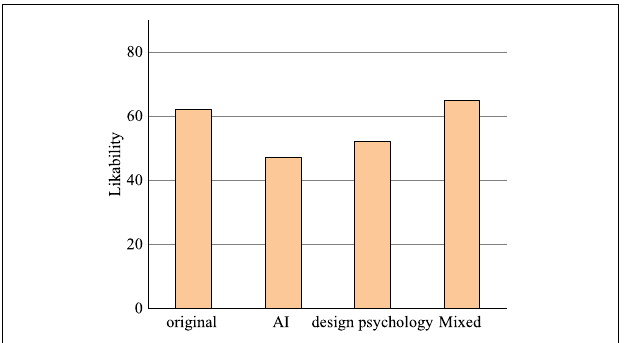
FIGURE 11 | Statistical chart of likability score survey after modification by different approaches.